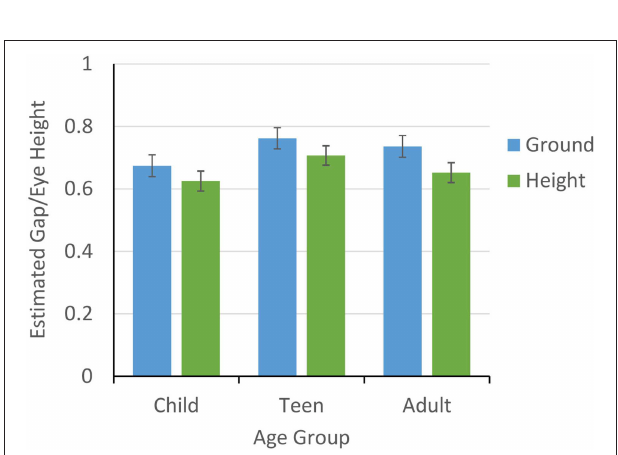
FIGURE 5 | Mean ( ± 1 SE) gap estimates scaled by eye height for child, teen, and adult age groups.